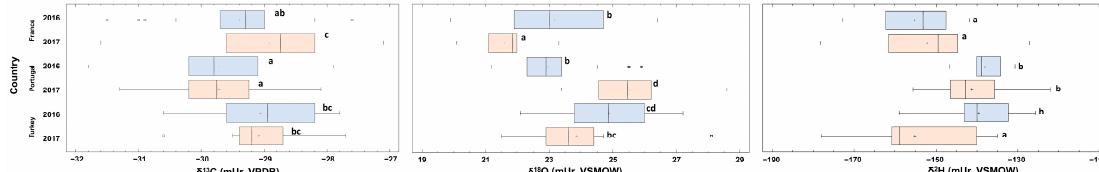
Figure 1. Boxplots of the bulk carbon ( δ 13 C values, a ), oxygen ( δ 18 O values, b ) and hydrogen ( δ 2 H values, c ) isotope composition of olive oils from three Mediterranean countries (France, Portugal and Turkey) in two harvest years (2016 and 2017). Boxplots display the ranges, lower and upper quartiles (Q1, Q3), and the median (Q2). Box plots with di ff erent letters indicate significant di ff erence (ANOVA; Means compared using Tukey test, p =